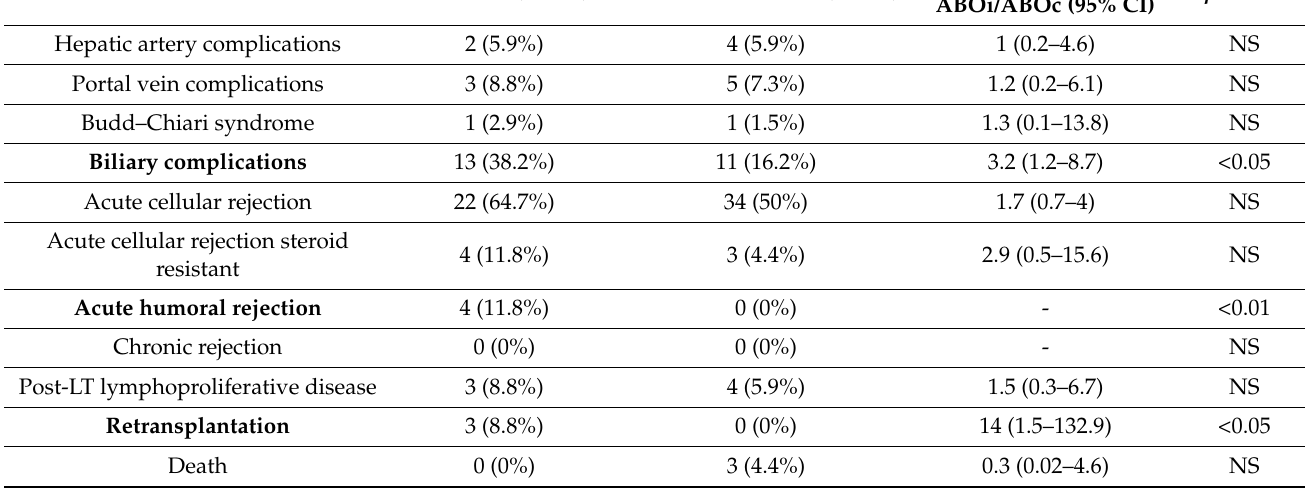
Table 2. Post-transplant complications according to ABO compatibility between donor and recipient among 34 ABOi and 68 non-ABOi pediatric liver transplantations performed at the Cliniques Universitaires St Luc, Brussels, Belgium (September 2003–August 2019).